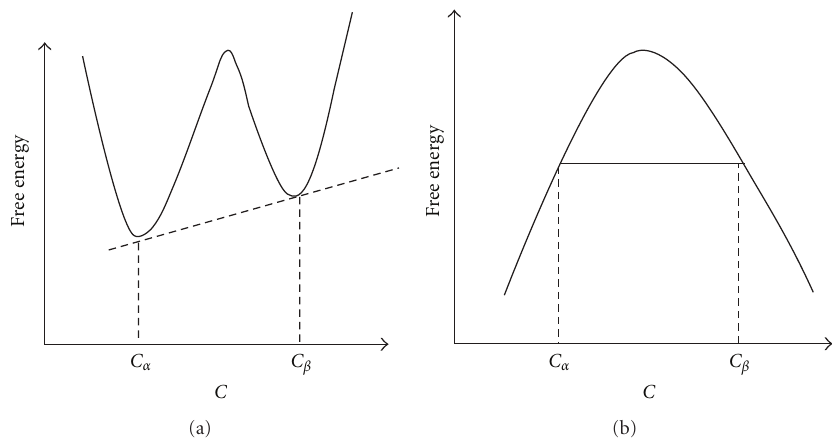
Figure 4: Free energy diagram of a binary mixture